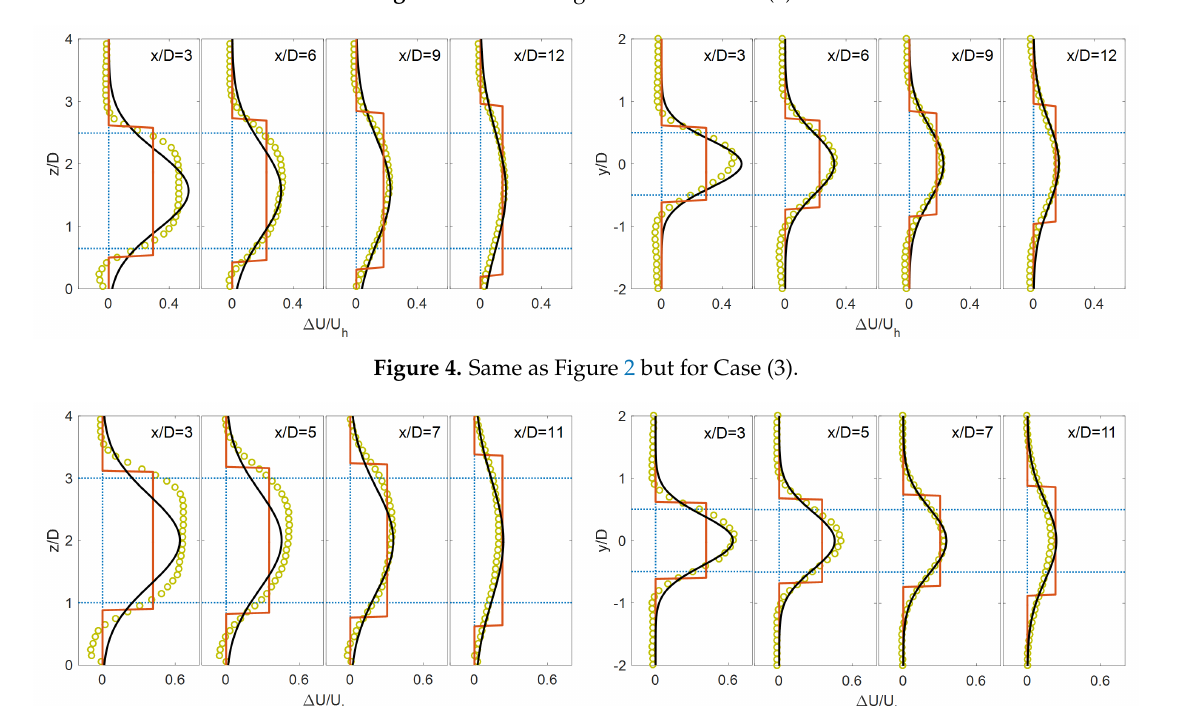
Figure 5. Same as Figure 2 but for Case (4). The LES data (open circle) was extracted from Shamsoddin and Porté-Agel